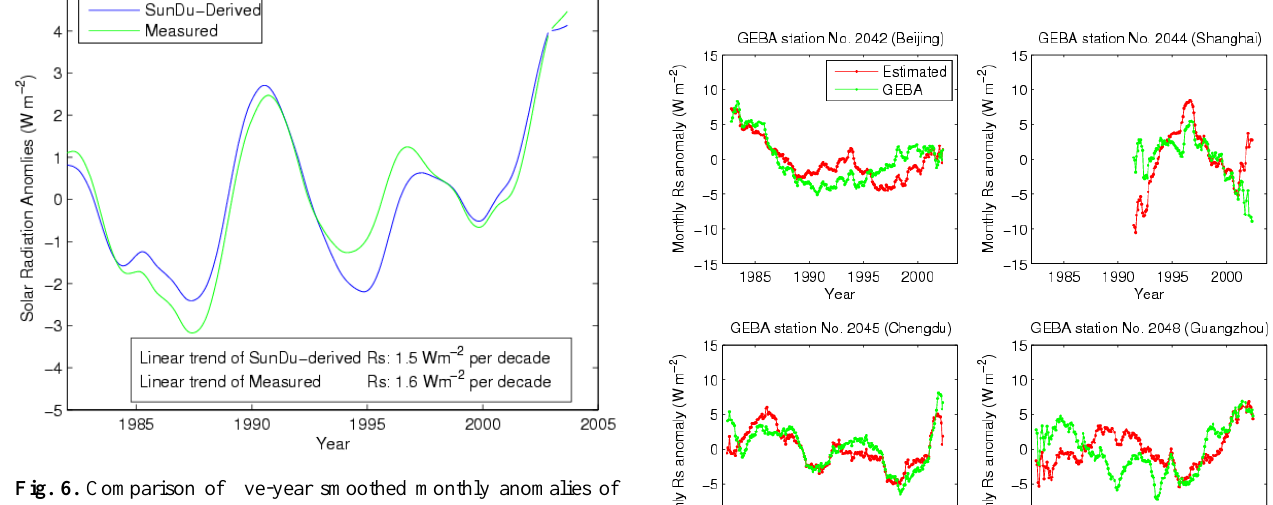
Fig. 7. Comparison of five-year smoothed monthly anomalies of SunDu-derived with directly-measured R s averaged over 51 stations in China (Table 1). The sharp increase around 1991 in measured R s occurred when Russian-made pyranometers (Type: DFY) were replaced by Chinese-made pyranometers (Type: TBS) from 1990 to the spring of 1993.